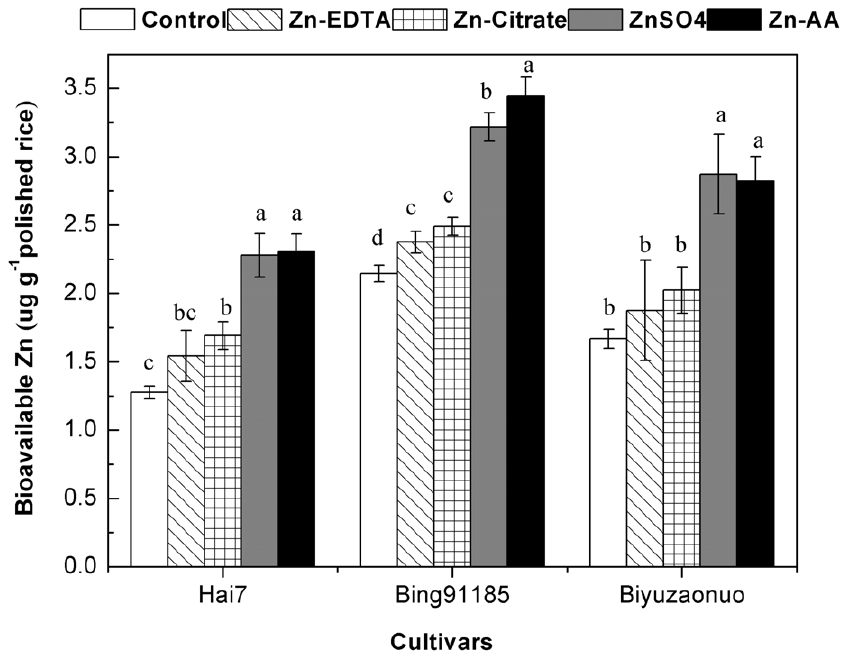
Figure 3. The amount of bioavailable Zn in the polished rice among three cultivars. Error bars indicate standard errors of the means (n=4). Different letters indicate significant difference among Zn treatments according to LSD test (P ,